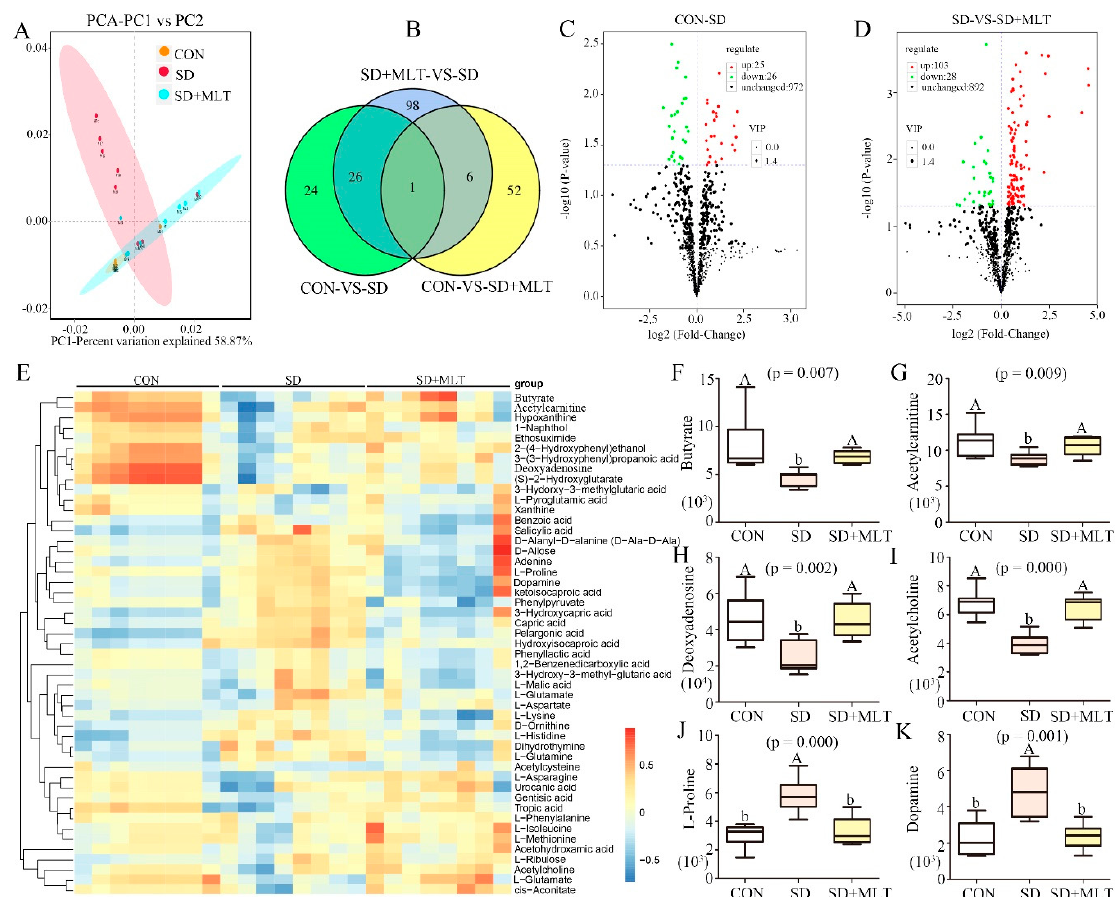
Figure 3. Composition of the colon microbiota metabolites in SD mice with or without melatonin supplementation ( n = 8). The β -diversity of principal component analysis (PCA) ( A ) and Venn based on the microbiota metabolites ( B ) in the CON, SD, and SD + MLT groups; volcano plot based on the differential metabolite screening ( C ), compared with the CON and SD groups; volcano plot based on the differential metabolite screening ( D ), compared with the SD and SD + MLT groups; heatmap showing the relative abundance of the key identified 49 metabolites that were significantly altered by melatonin in SD mice ( E ). The relative abundance of butyrate ( F ), acetylcarnitine ( G ), deoxyadenosine ( H ), acetylcholine ( I ), L-proline ( J ), and dopamine ( K ) in the CON, SD, and SD + MLT groups in the colon microbiota based on the heatmap results. CON: non-sleep-deprived control group; SD: sleep deprivation group; SD + MLT: SD + melatonin supplement group. Differences were assessed using ANOVA and are denoted as follows: different lowercase letters or different uppercase letters: p < 0.05; different letters and one contains uppercase letters and the other is lowercase letters: p < 0.01; same letter: p >